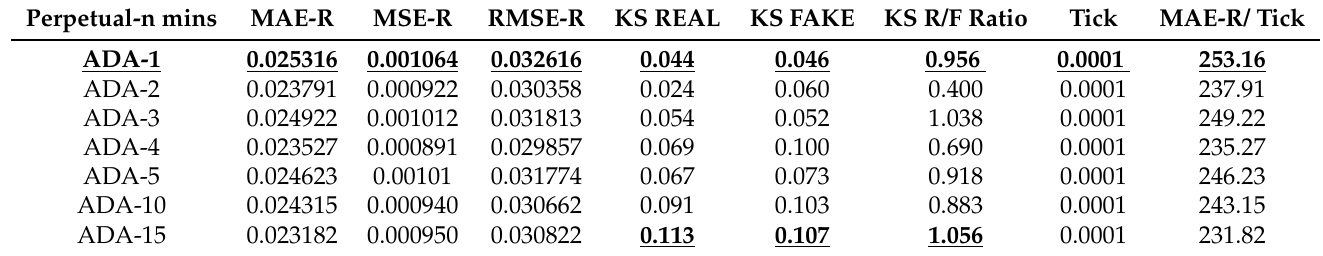
Table 19. We compare ADAUSDT perpetual futures at multiple time intervals.